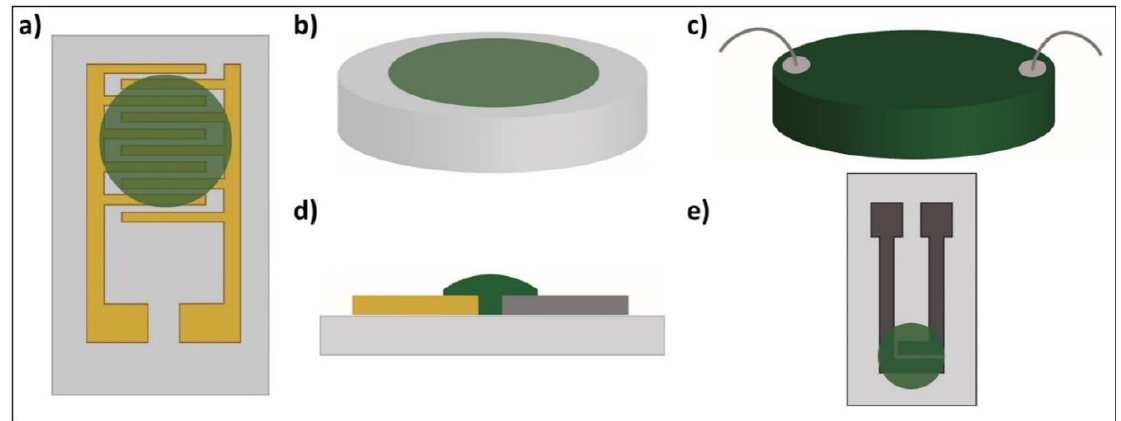
Figure 1. Polyaniline (PANI)-based ammonia/humidity gas sensors: ( a ) interdigitated electrodes [8,9,21,30,36]; ( b ) film [40]; ( c ) pellet [38]; ( d ) two different metal electrodes [39]; ( e ) screen-printed two-electrode system [37].